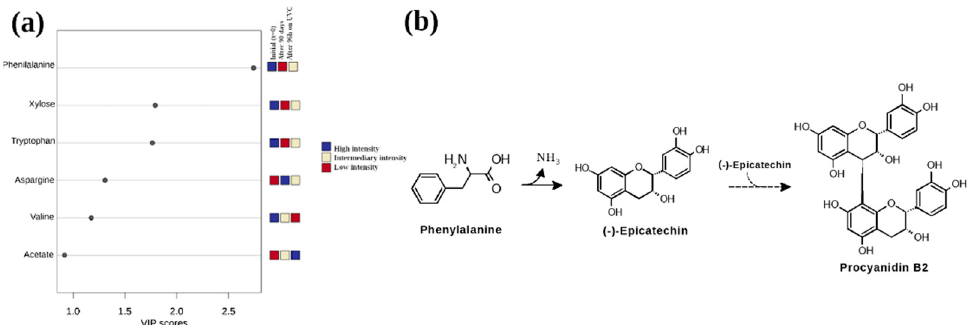
Figure 4. ( a ) Relevant metabolites discriminated by PLS-DA in a VIP projection. The colored boxes on the right indicate the relative area intensity of the corresponding metabolites in each of the groups studied. ( b ) Simplified reaction of the proposed model of the procyanidin biosynthesis pathway in the tegument from phenylalanine, in agreement with observations in this work for the bean genotypes addressed.